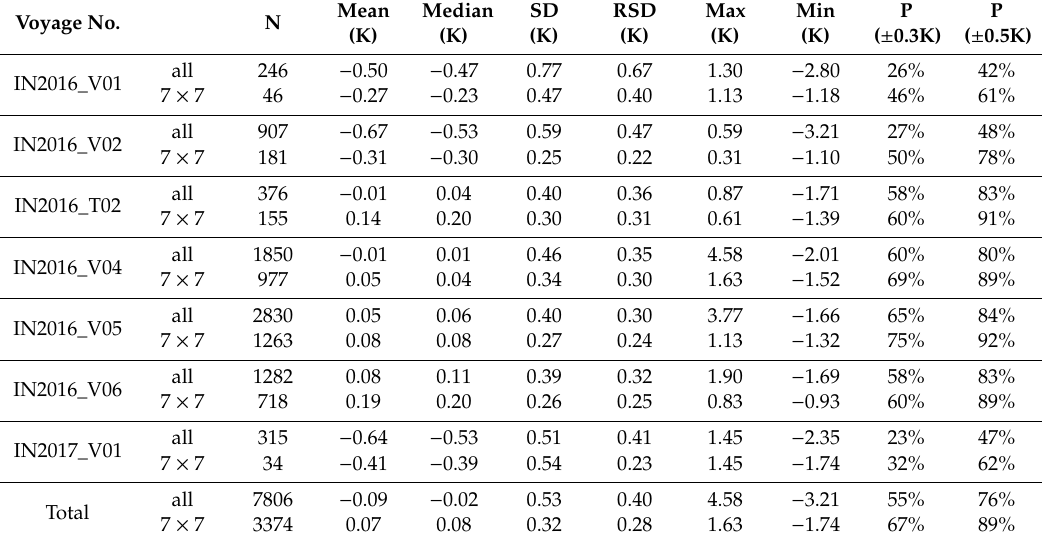
Table 2. Statistics of the SST di ff erence of the matchups for each cruise (number of matchups (N); standard deviation (SD) and robust standard deviation (RSD); maximum (Max) and minimum (Min) values; P( ± 0.3K) and P( ± 0.5K) are the percentages within 0.3 K and 0.5 K, which are the matchups.). Voyage